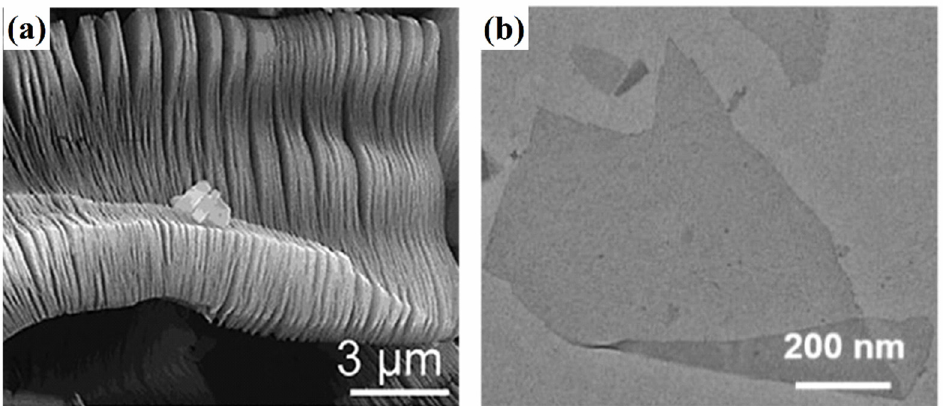
Figure 3. ( a ) Scanning electron microscopy image of the accordion-like multilayer MXene structure (Reprinted with permission from Ref. [34]. Copyright 2012, copyright ACS). ( b ) Transmission electron microscopy image of single-layer MXene nanosheets (Reprinted with permission from Ref. [35]. Copyright 2020, copyright Elsevier).